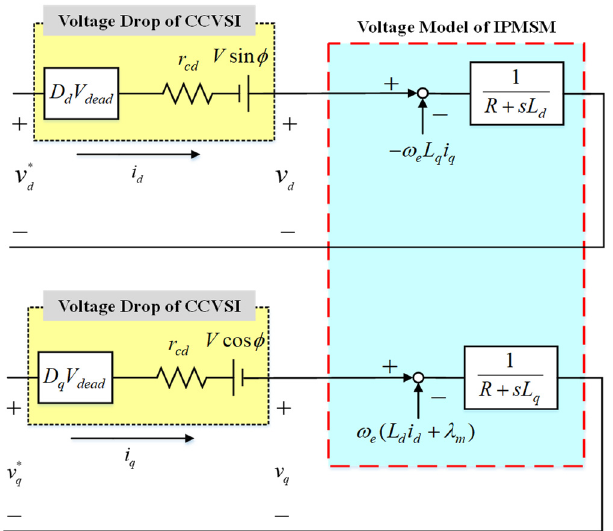
Figure 3. The dq -axis circuit model including the CCVSI nonlinearity.